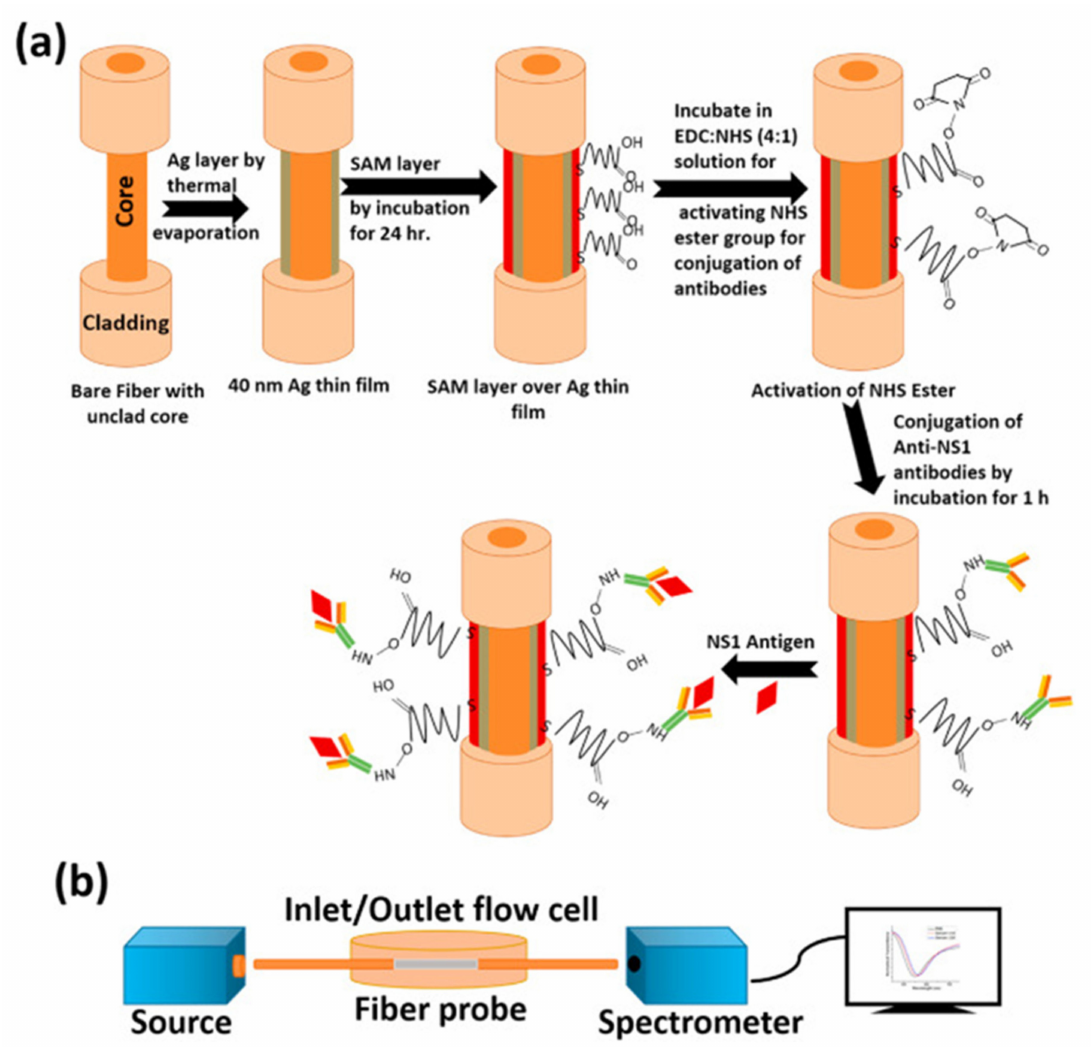
Figure 18. ( a ) Fabrication steps of fiber optic SPR probe for NS1 antigen based dengue detection, and ( b ) schematic of experimental set-up. Reprinted with permission from Ref. [101]. Copyright 2022